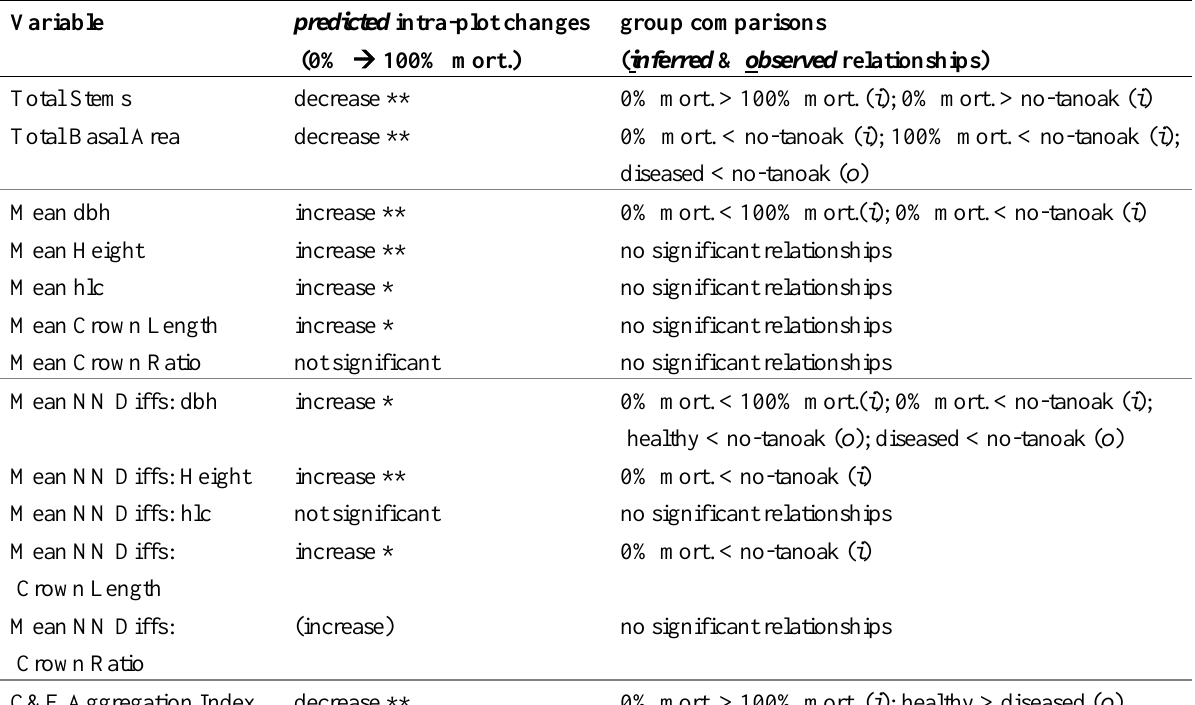
Table 2. Summary of main results. The “ predicted intra-plot changes” column